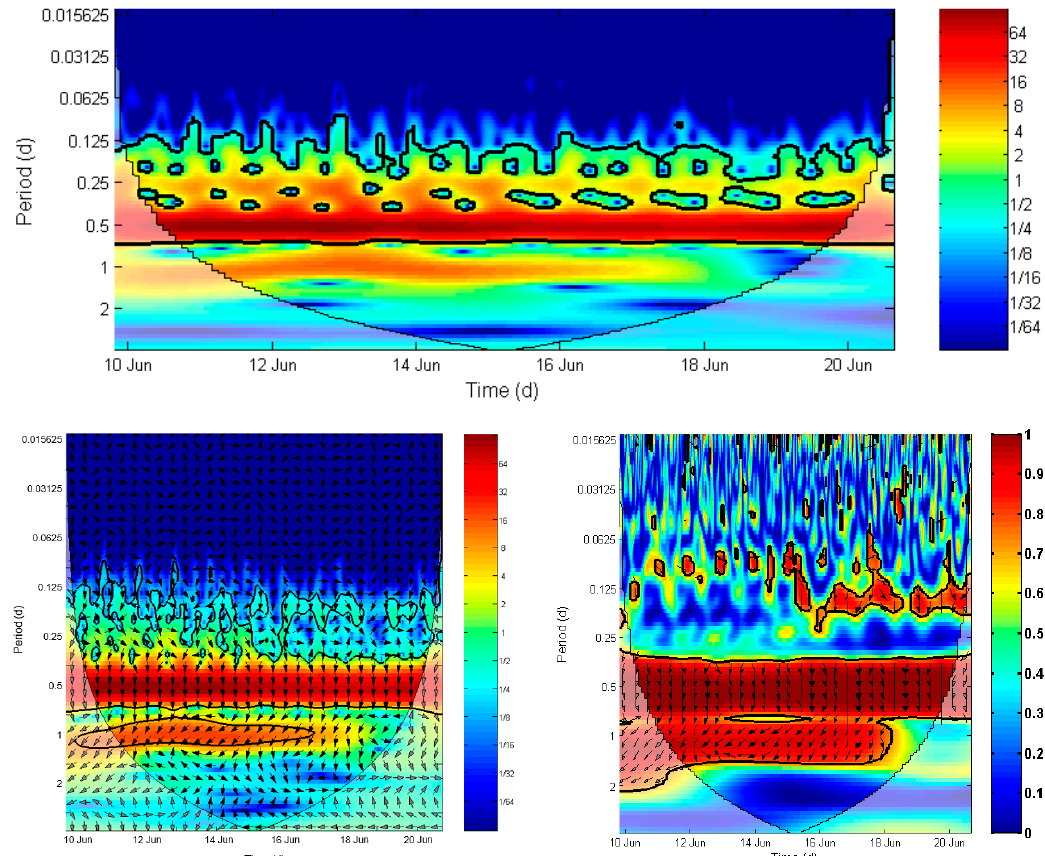
Figure 8. Wavelet analyses in western branch: (top) continuous wavelet transform. (bottom left) cross-wavelet transform. (bottom right) wavelet coherence. The black contours represent the 0.95 confidence level against red noise and the cone of influence (COI) where edge e ff ects might distort the picture is shown as a lighter shade. The relative phase relationship is shown as arrows (with in-phase pointing right, anti-phase pointing left, and the first time series leads the second one by 90 ◦ pointing down). The wavelet power is log ( A 2 / v ), where A is the wavelet amplitude, v is the variance of the original tidal signals. The y -axis in the continuous wavelet transformation (CWT) and cross-wavelet transformation (XWT) is on a log 2 scale.